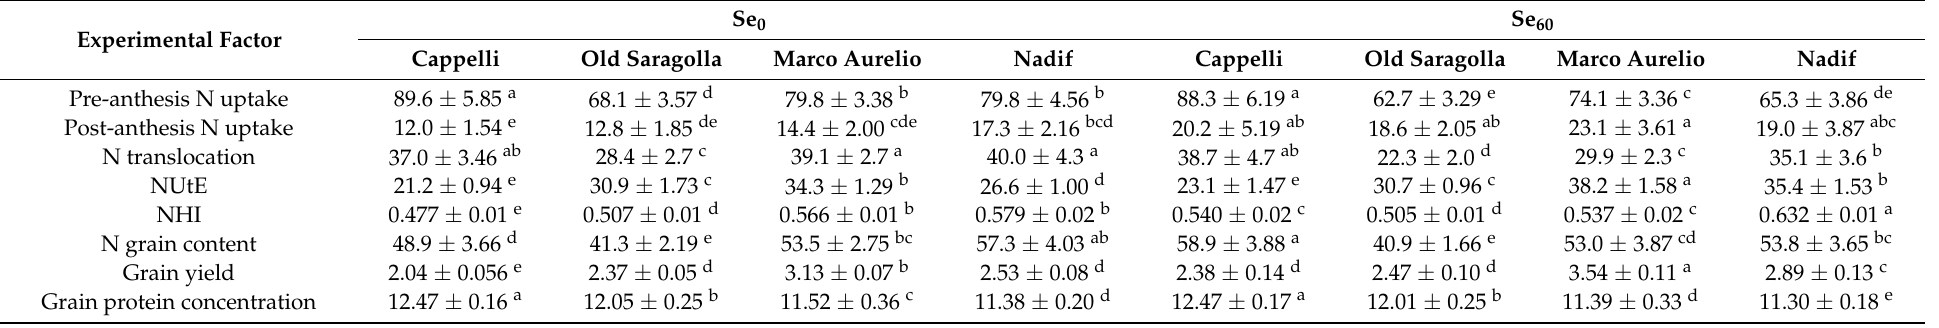
Table 3. Effect of interaction selenium application × variety on pre-anthesis N uptake (kg ha − 1 ), post-anthesis N uptake (kg ha − 1 ), N translocation (kg ha − 1 ), nitrogen utilization efficiency (NUtE; kg kg − 1 ), nitrogen harvest index (NHI; kg kg − 1 ), N grain content (kg ha − 1 ), grain yield (t ha − 1 ) and grain protein concentration (%). Se0, no selenium application; Se60,